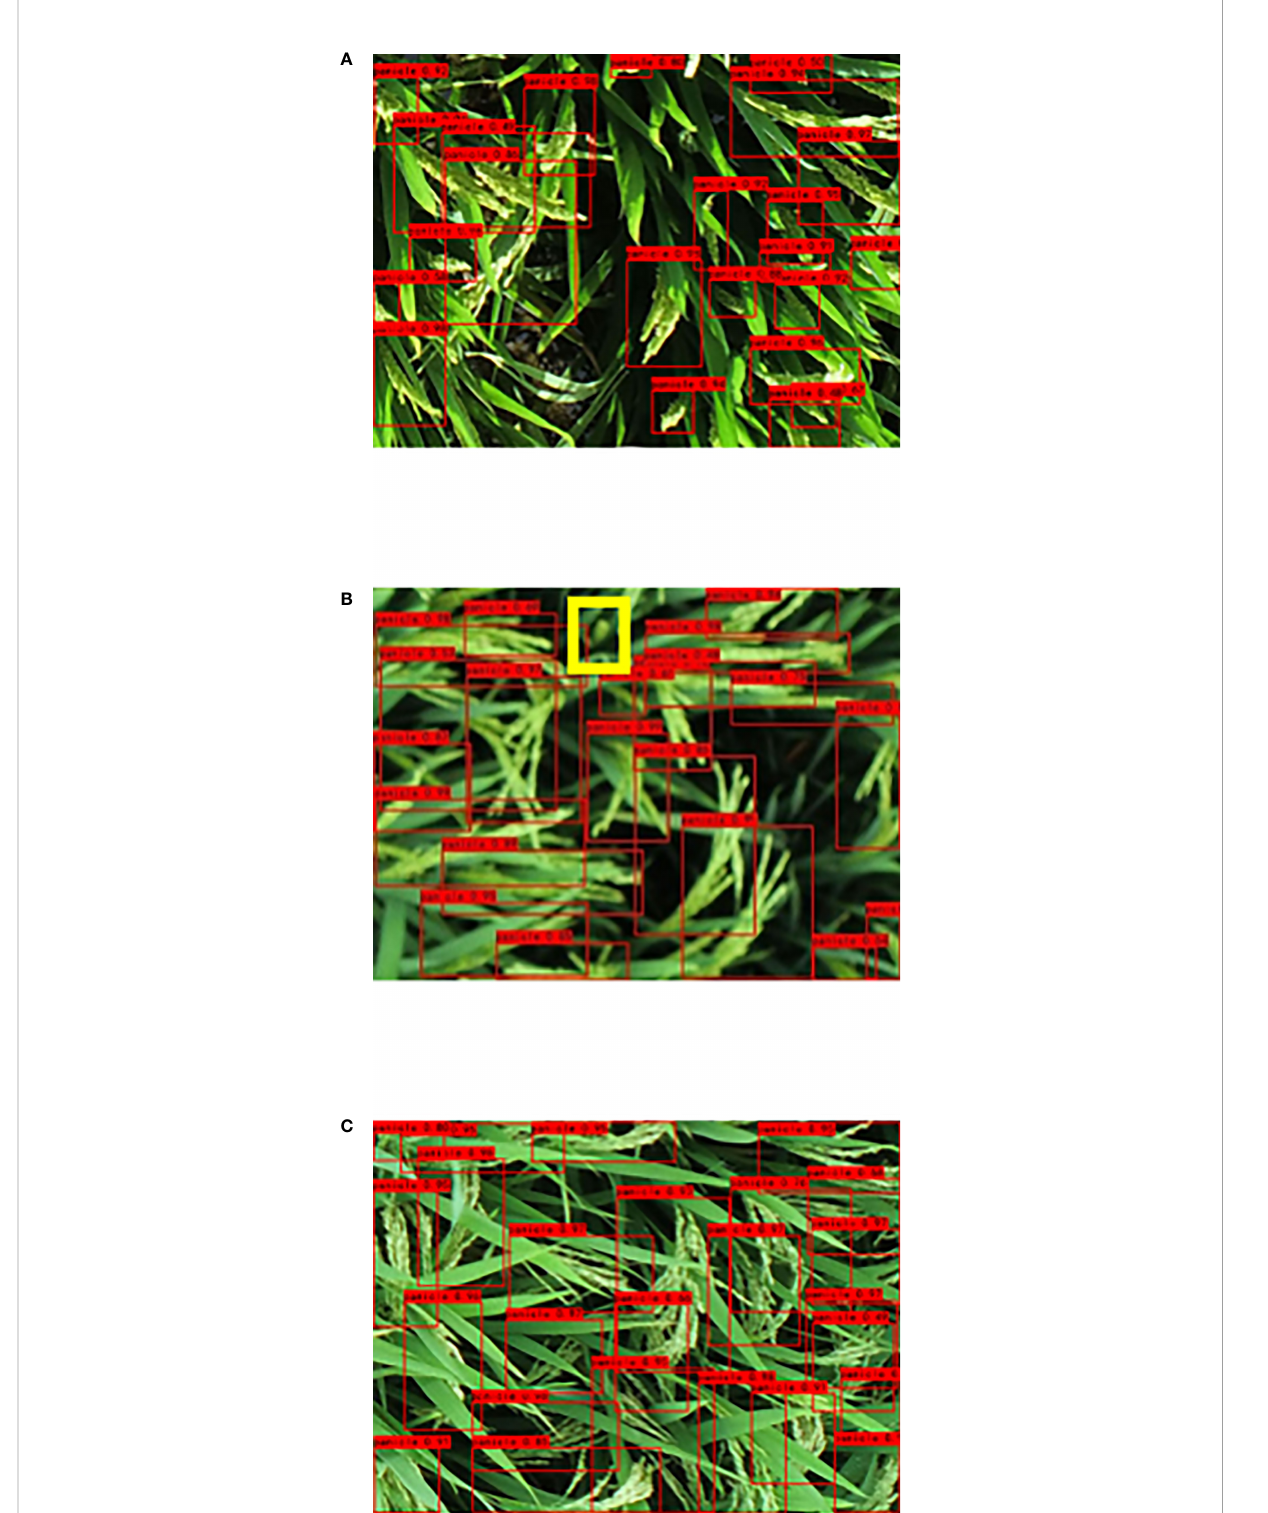
FIGURE 8 Effect of different complex environments on the recognition of scattered panicle in a large fi eld. (A) Image taken using strong exposure; (B) UAV image of canopy disturbance; (C) Scattered panicle in complex